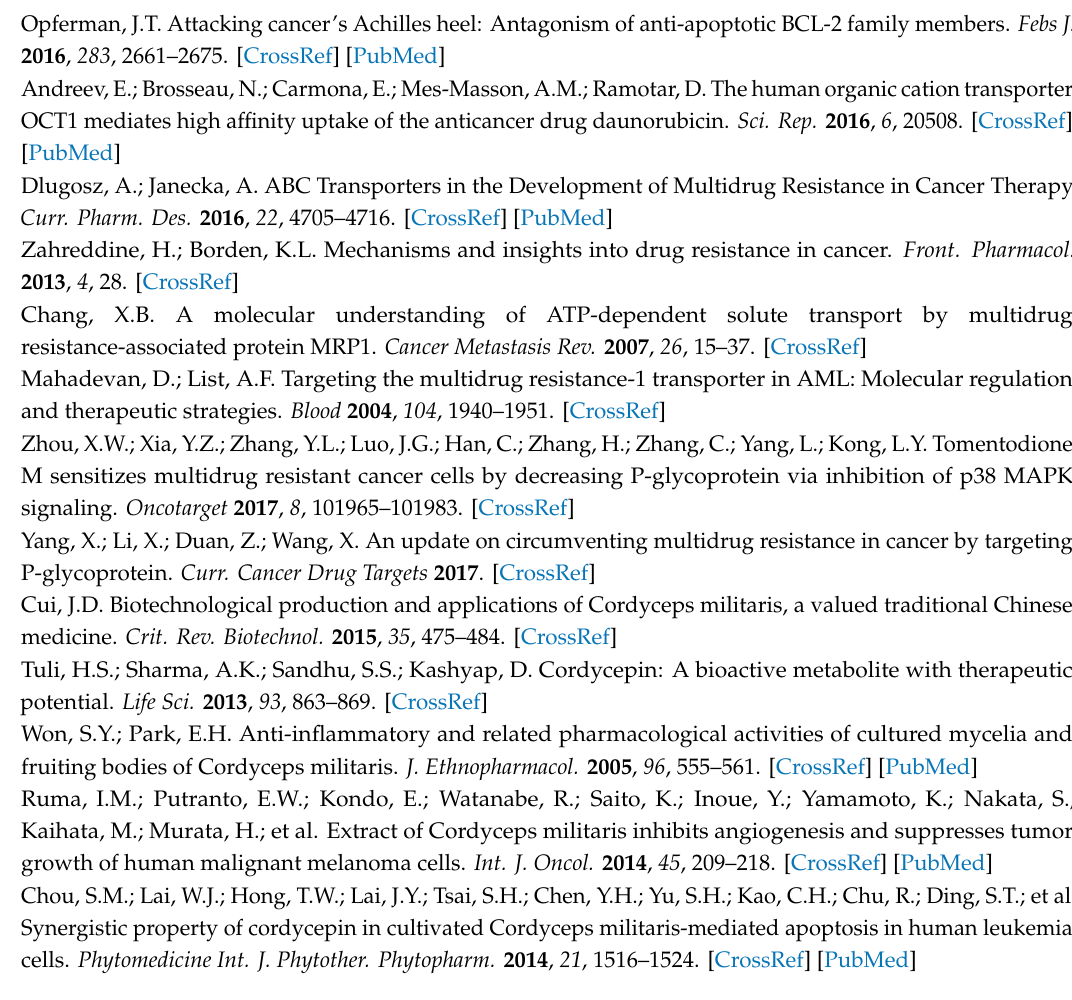
Figure S1: Cordycepin inhibits active phosphorylation of